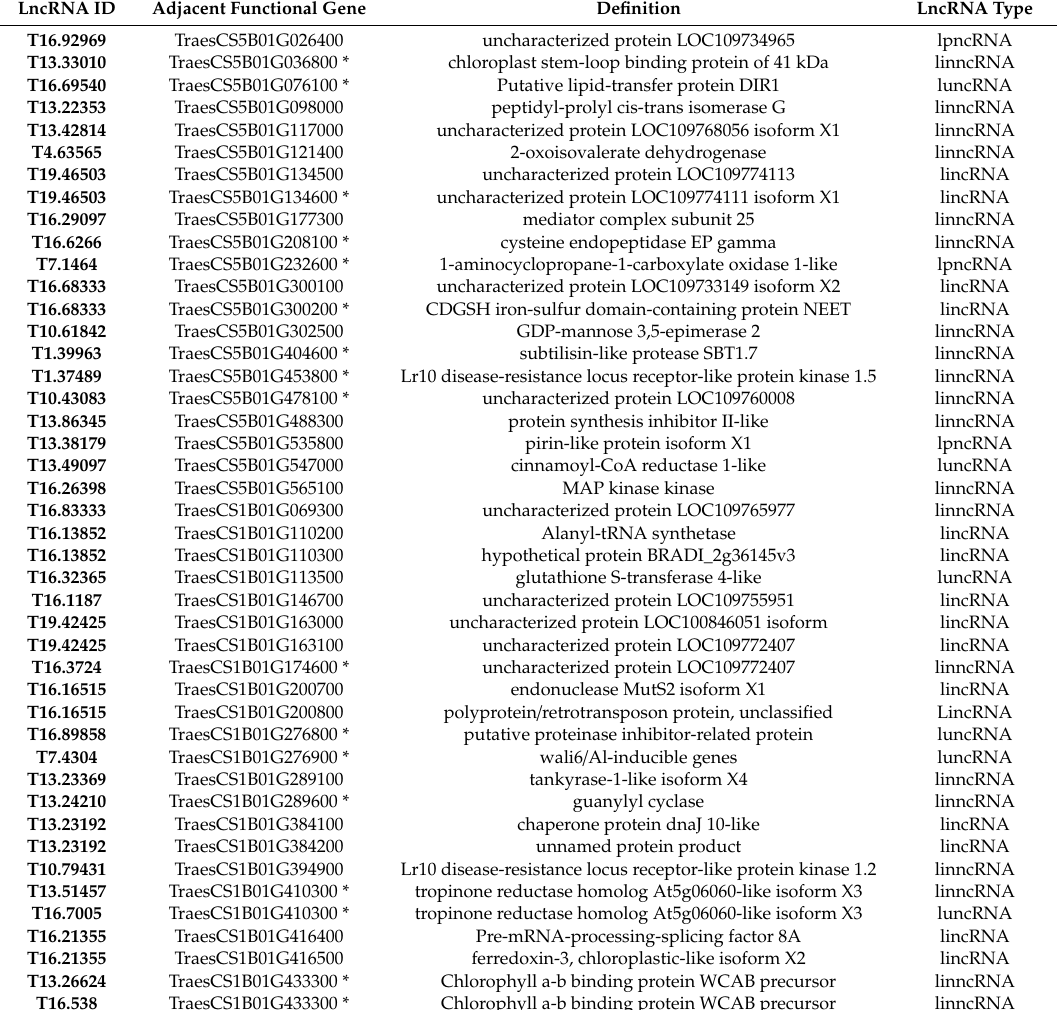
Table 2. The list of DE-lncRNAs with adjacent functional gene in chromosome 1B and